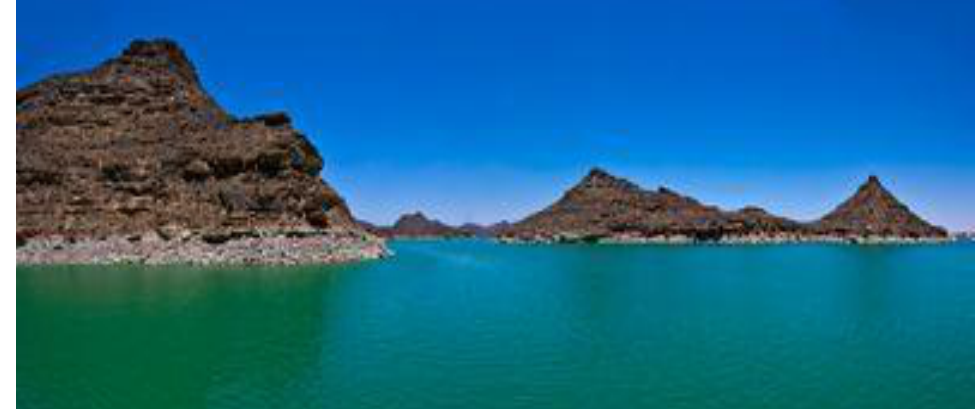
Figure 1. Location of Lake Nasser, Egpt.